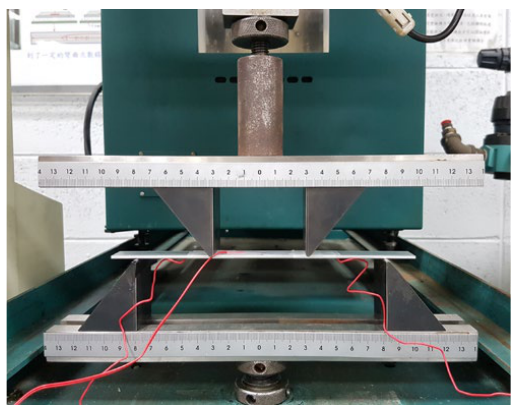
Figure 11. Experimental setup of the four-point bending test.